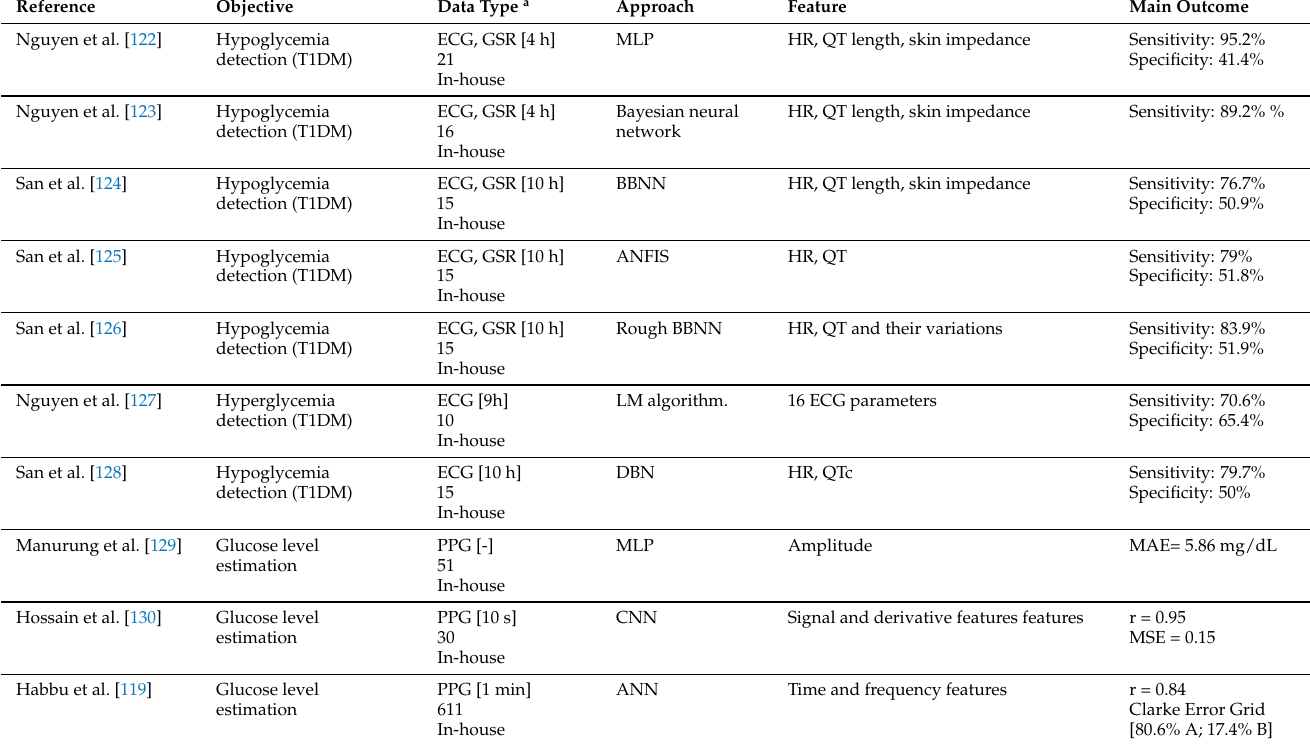
Table 9. Deep learning methods for blood glucose estimation and